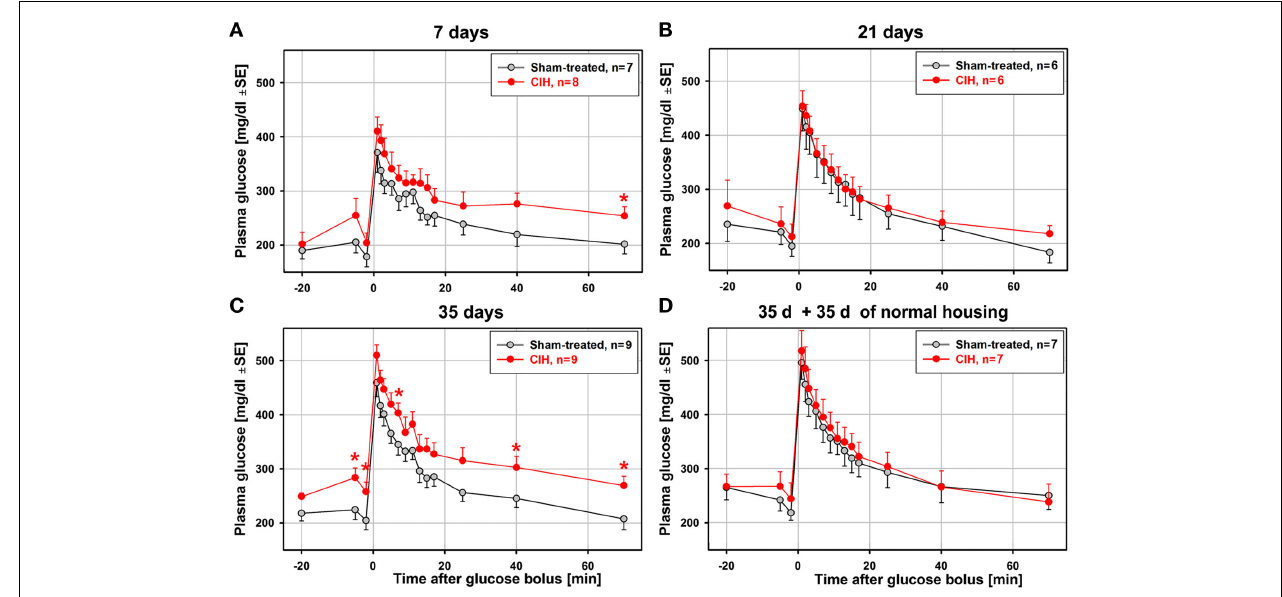
was mainly related to the elevation of baseline glucose levels in the CIH rats prior to glucose bolus injection (at time zero). In the rats subjected to CIH or sham treatment for 35days and then housed normally for another 35days, the glucose clearance curves did not differ between CIH and sham-exposed rats (D) . *Indicates p < 0.05 relative to the corresponding sham-treated group at the same time